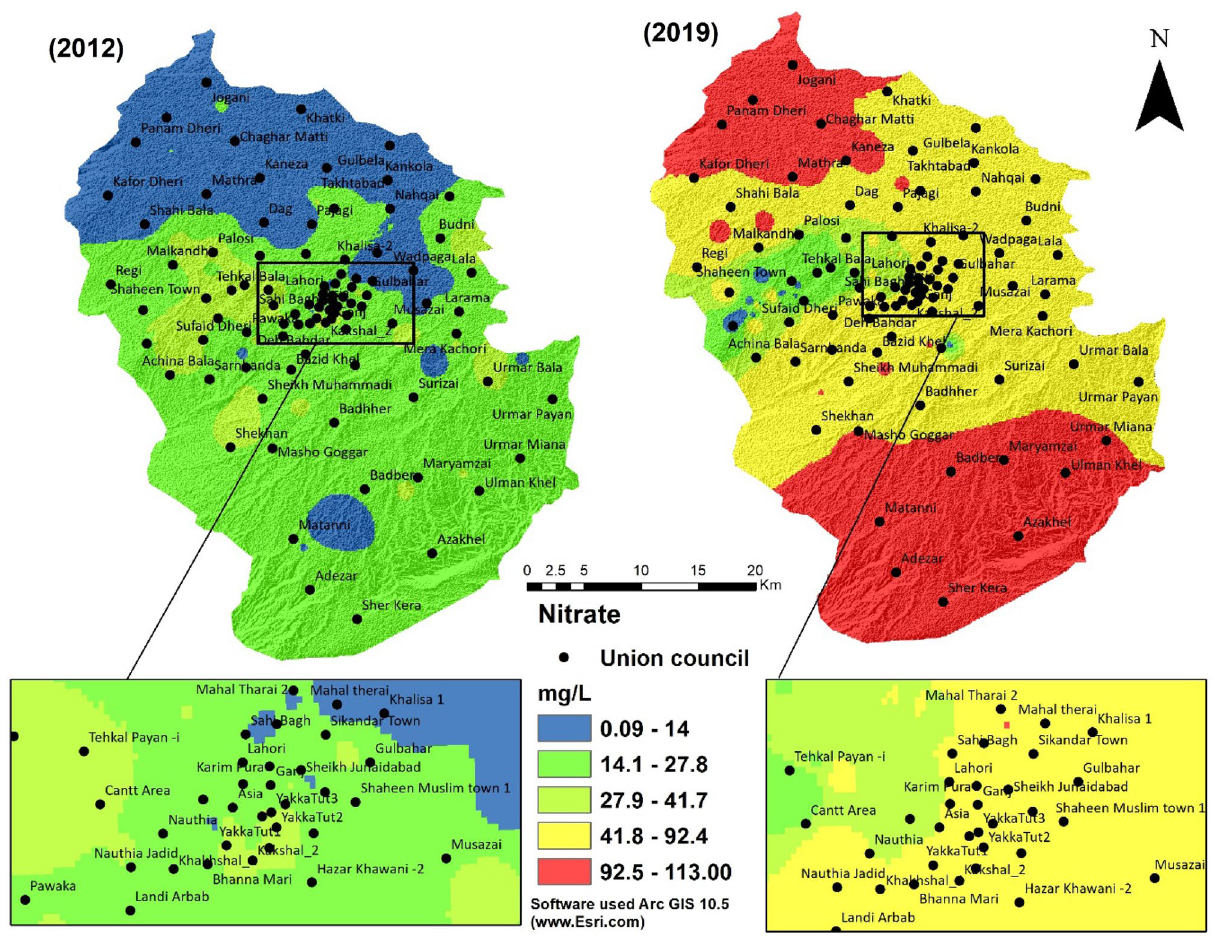
Figure 5. Nitrate of groundwater in the periods 2012 and 2019.